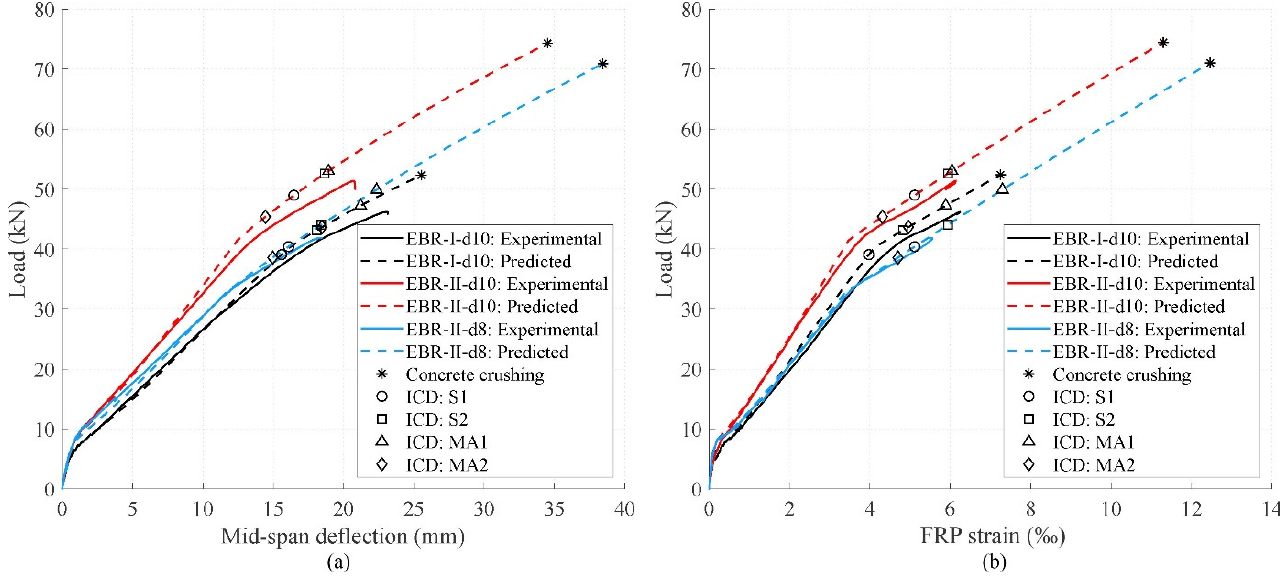
Figure 7. Behaviour of tested specimens: ( a ) load-deflection curves and ( b ) load-strain curves.